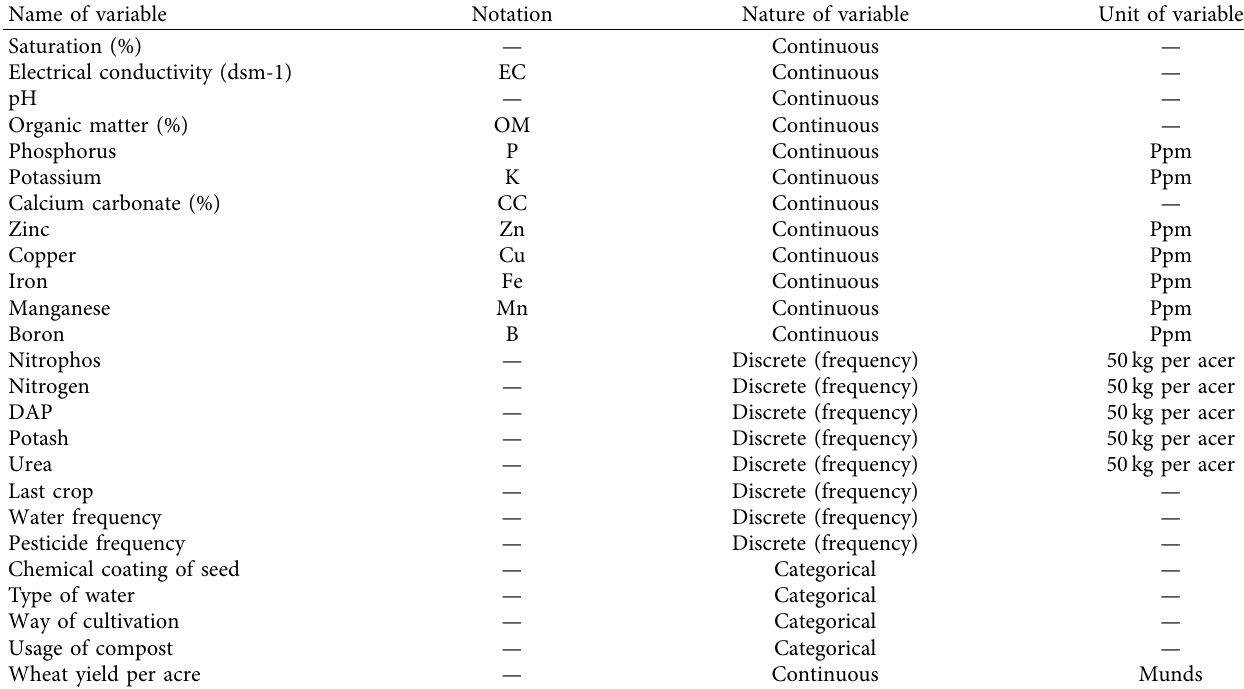
Table 2: Description of wheat yield and its associated factors.